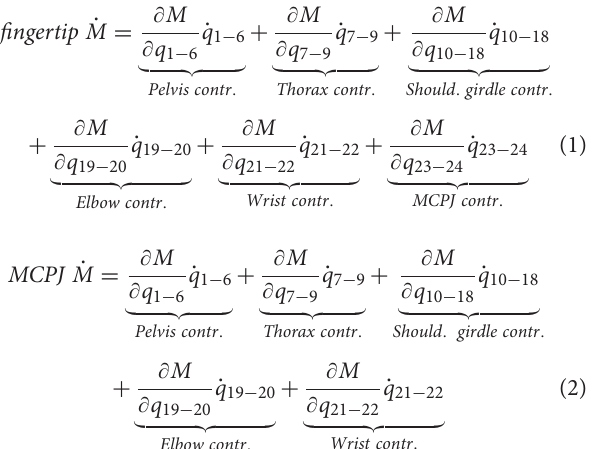
(DoF) kinematic model